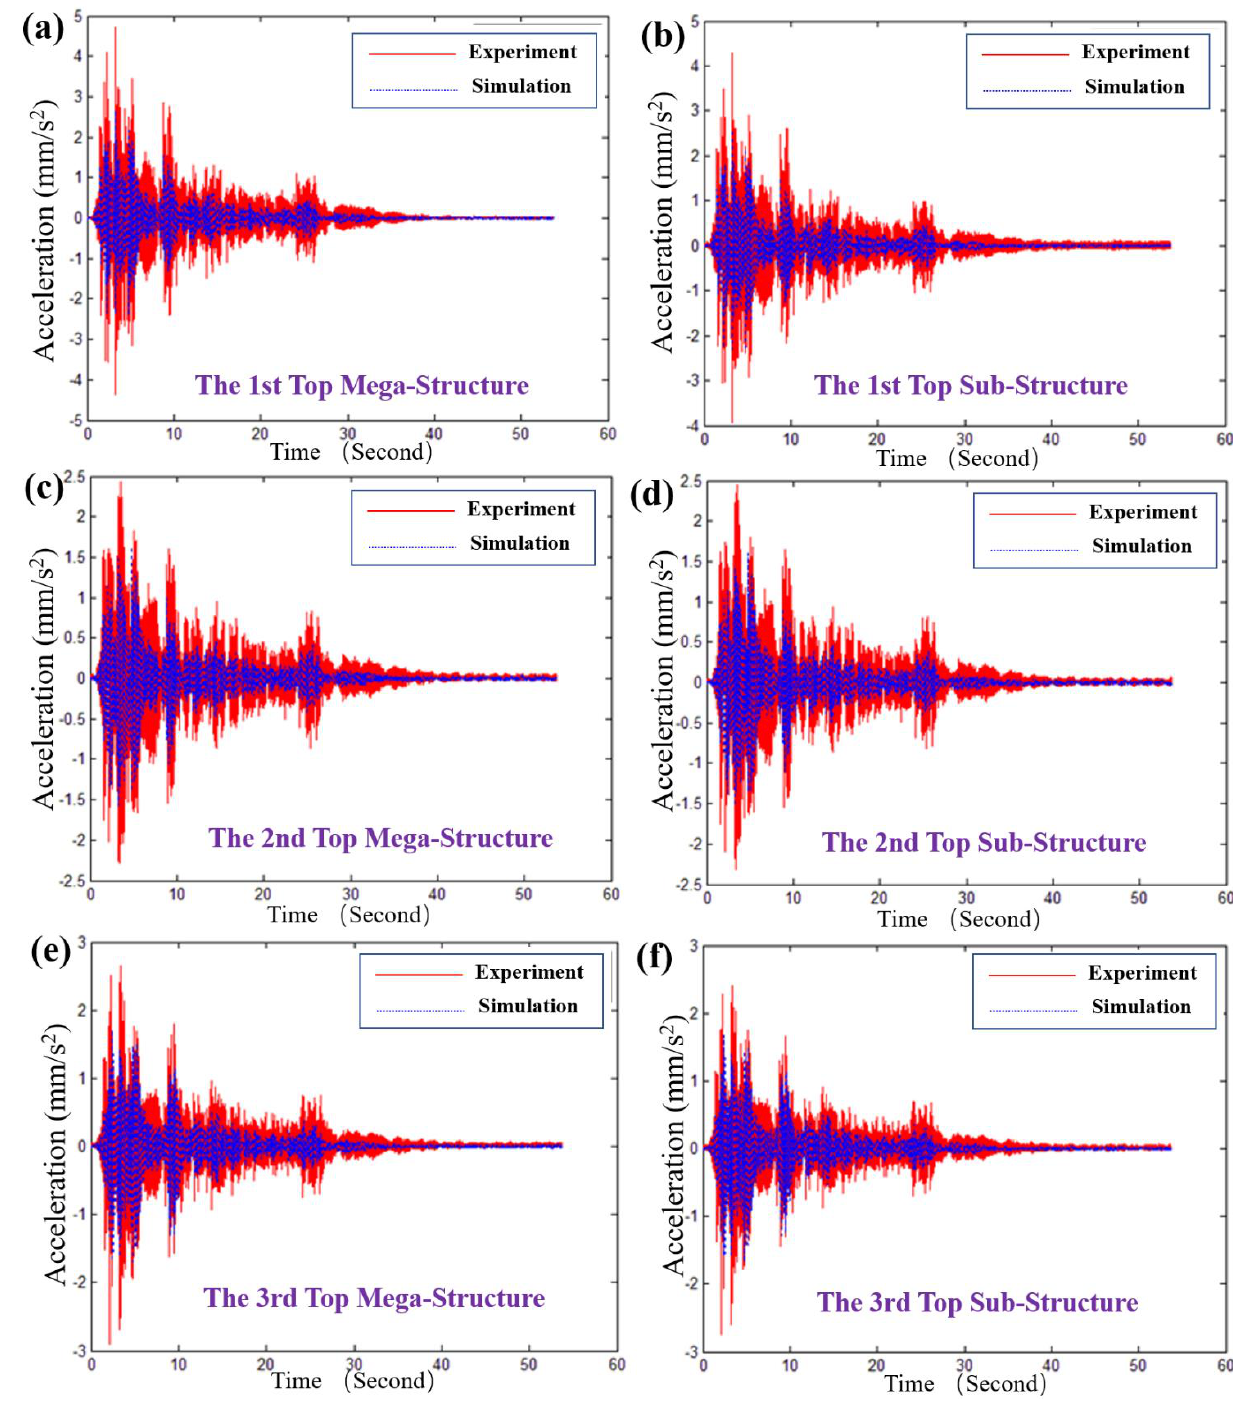
Figure 7. The acceleration response of the typical structural unit of MSCSS0001 to the El Centro wave: ( a ) the top of the first megaframe; ( b ) the top of the first substructure; ( c ) the top of the second megaframe; ( d ) the top of the second substructure; ( e ) the top of the third megaframe; ( f ) the top of the third substructure.